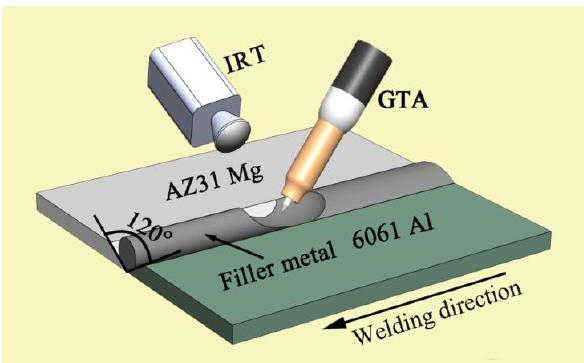
Figure 1. Schematic illustrations of gas tungsten arc (GTA) butt welding. IRT, infrared